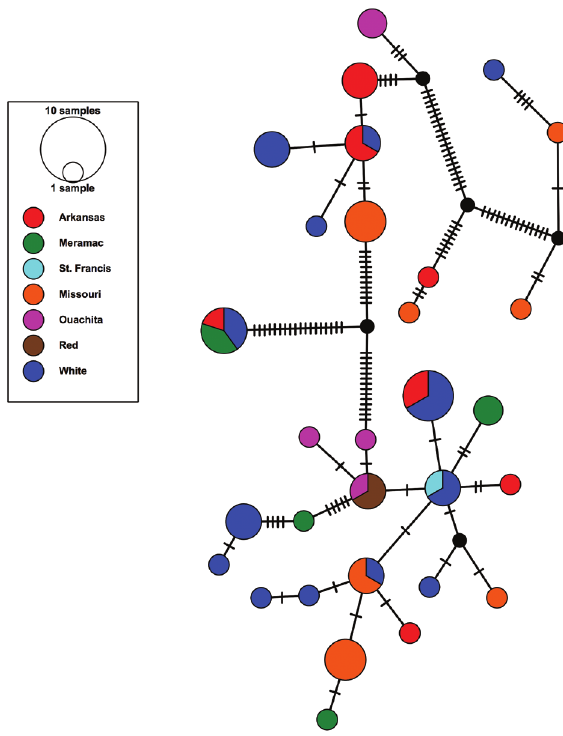
Figure 3. TCS parsimony network of E. potosiensis 16S haplo- types color coded by river drainage. Hash marks represent mu- tational steps between haplotypes.